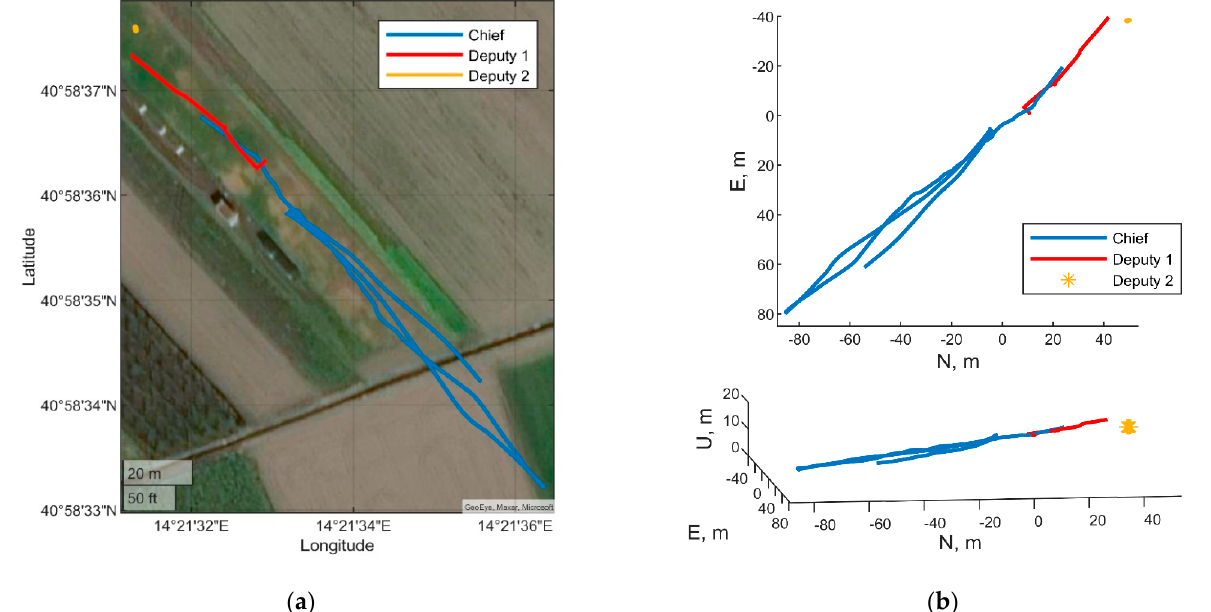
Figure 22. Path of the chief and the two deputies. Two deputies case: ( a ) Longitude, latitude coordinates, ( b ) ENU coordinates top view and 3D view.